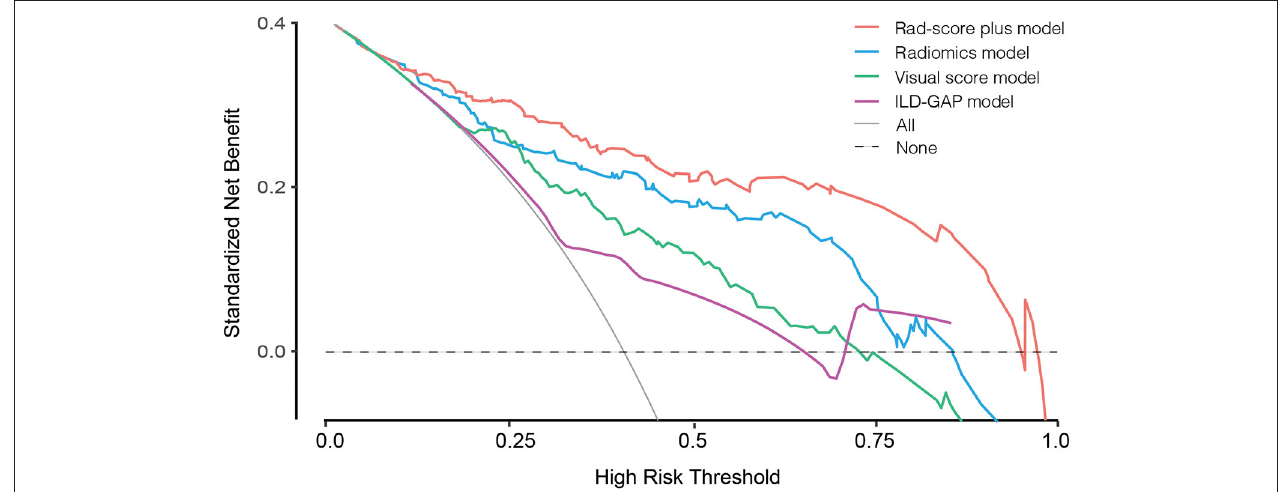
FIGURE 3 | Calibration curves for the visual score model (green line), radiomics model (blue line), Rad-score plus model (red line), and ILD-GAP model (purple line). Calibration curves showed the calibration of each model in terms of the agreement between the predicted and observed 6-month outcomes. Nomogram-predicted outcome was plotted on the x-axis; the observed 6-month survival probability was plotted on the y-axis. Diagonal dotted line referred to perfect estimation by an ideal model, in which the predicted outcome perfectly corresponded to the actual outcome. Solid line referred to performance of the nomogram, a closer lining of which with the diagonal dotted line indicated better